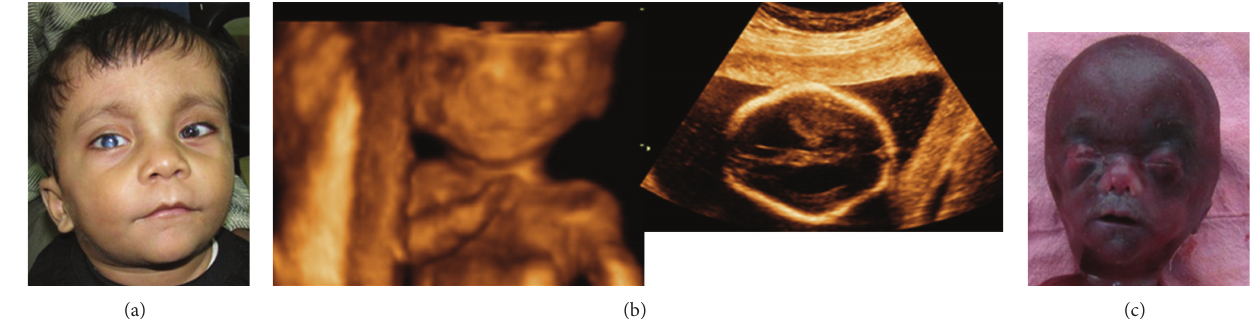
Figure1:(a)ProbandwithPeters’anomalyandfacialdysmorphism.(b)Ultrasoundshowing,longphiltrum,shortnoseandventriculomegaly. (c) Fetus with facial dysmorphism. Note prominent forehead, hypertelorism, long philtrum, short nose, anteverted nostrils, and thin upper lip.